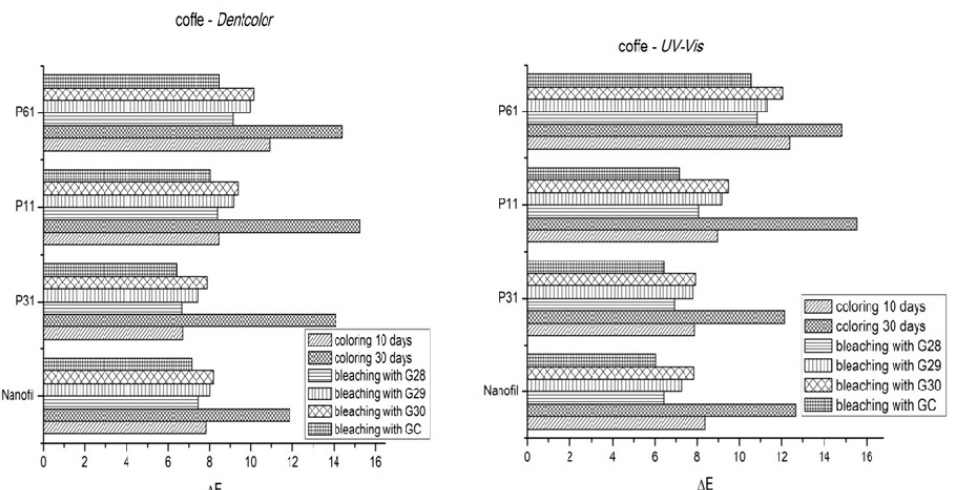
Figure 3. Δ E ab color difference values for experimental composite samples (P31, P11, P61) and commercial composite “Nanofill”, colored in “coffee” for 10 and 30 days, respectively, and bleached with natural gels G28, G29, G30 and comercial gel GC (Opalescence 15%), recorded by: ( a ) DENTCOLOR program with digitized images; ( b ) UV-VIS